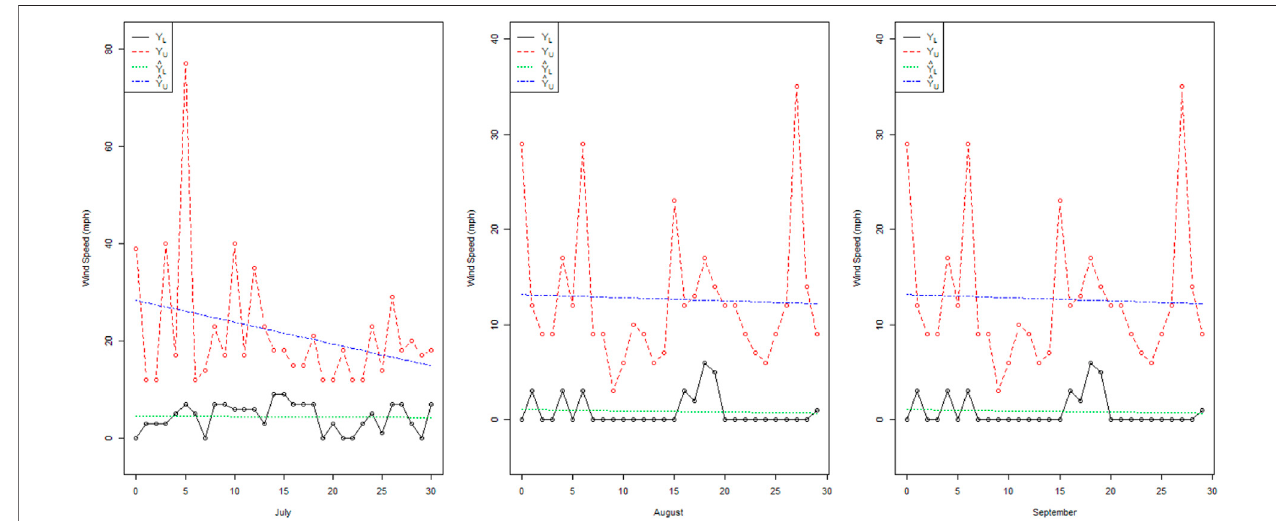
FIGURE 4 | Trended lines for July, August, and September.